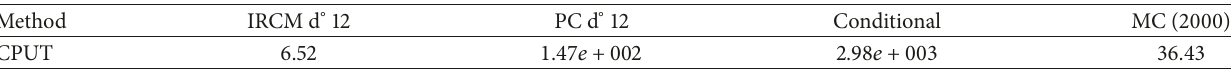
Table 6: CPU times to compute for IRCM, PC at degrees 12, MC (2000), and conditional